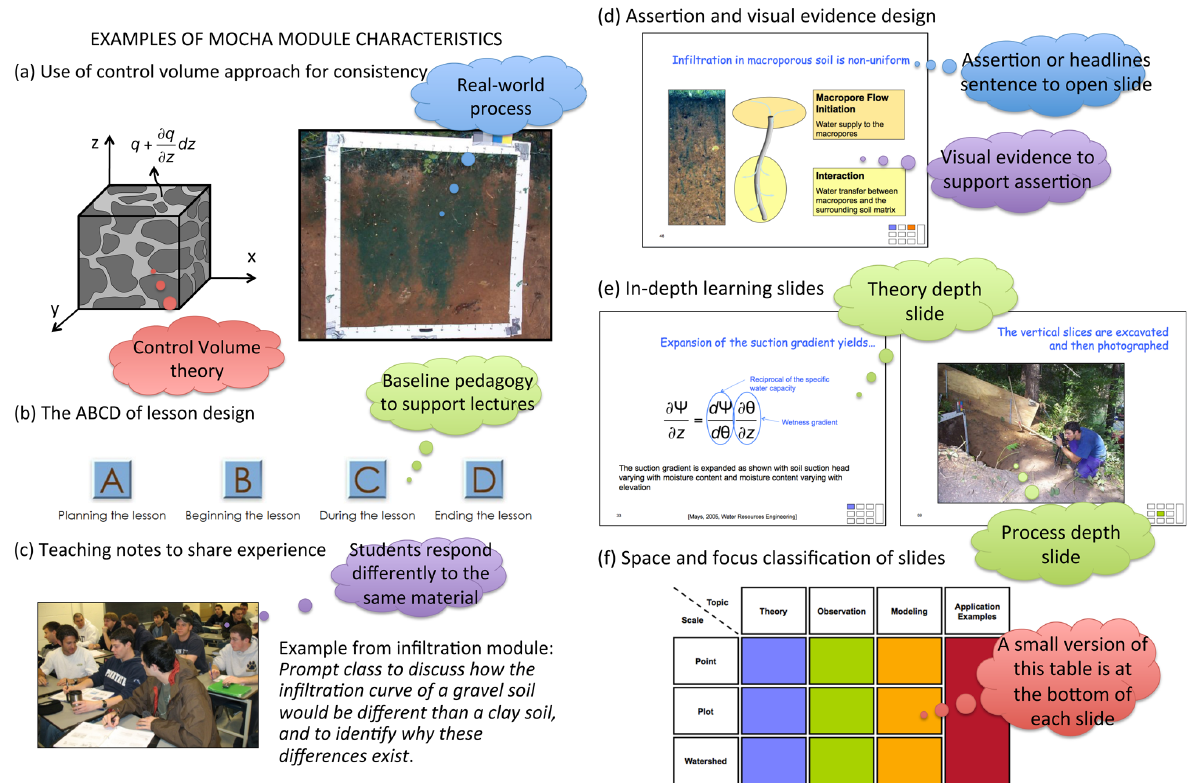
Fig. 2. Main characteristics of the MOCHA PPT